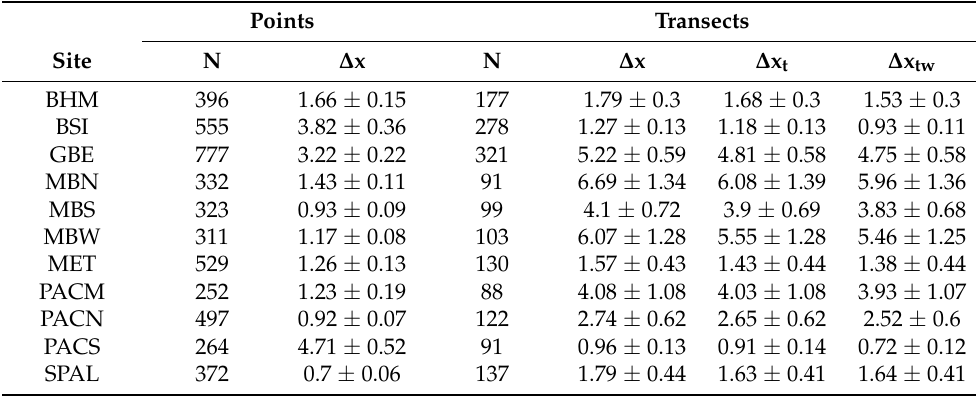
Table 3. Mean difference between Global Positioning System shorelines (GPSS) and WorldView- derived shorelines (WVS) ( ∆ x) by study site using both a point and transect-based method. Transect data were corrected for differences between collection date ( ∆ x t ) and water level ( ∆ x tw ). N is the number of points or transects for each study site.